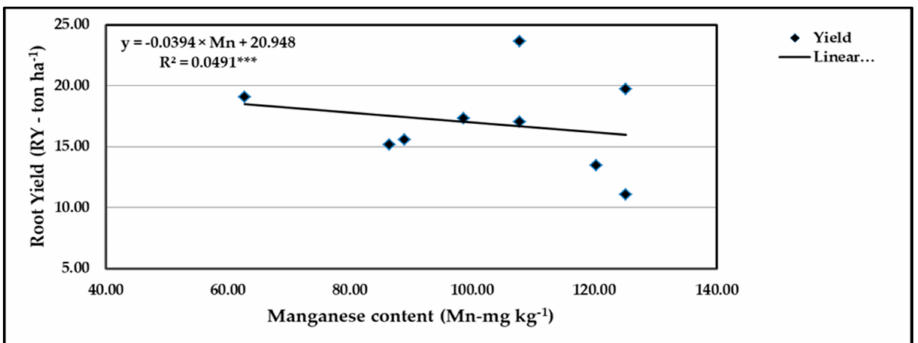
Figure 19. Contribution of Mn content to the quadratic response of stressed sweet potato to different levels of ascorbic acid and zinc oxide nanoparticles in the 2020 season. *** indicates differences at p ≤ 0.001 probability level.